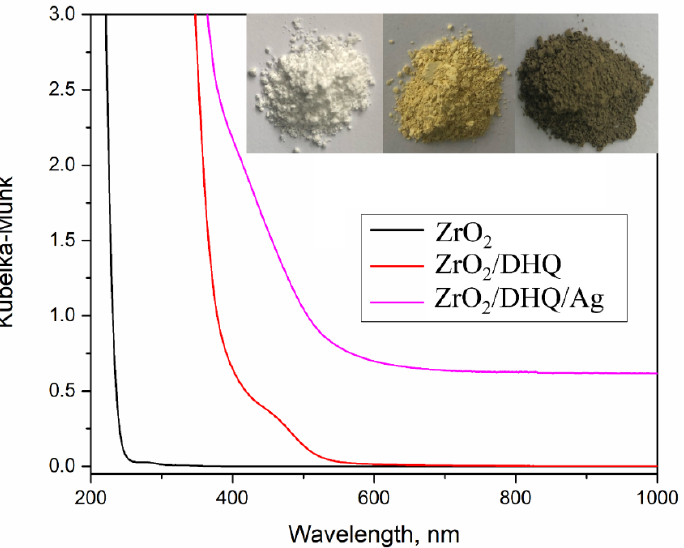
Figure 3. Kubelka-Munk transformations of UV-Vis-NIR diffuse reflection spectra of ZrO 2 , ZrO 2 /DHQ, and ZrO 2 /DHQ/Ag powders. Inset: photo images of ZrO 2 , ZrO 2 /DHQ, and ZrO 2 /DHQ/Ag from left to